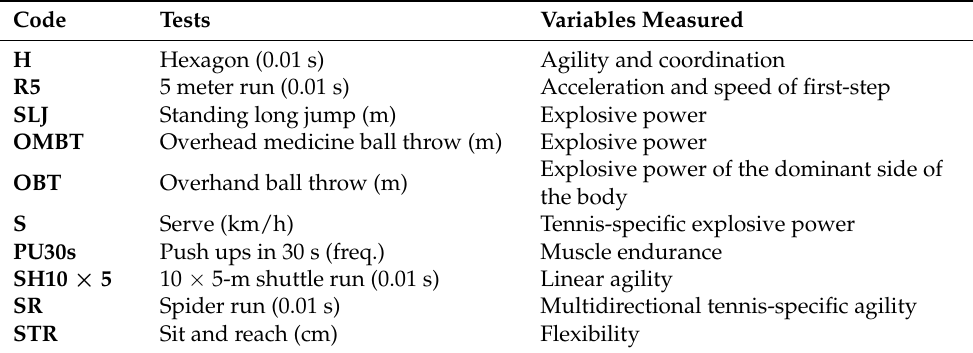
Table 1. The sequence and variables of selected field